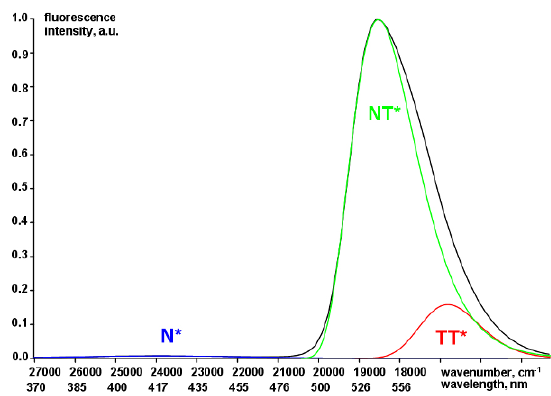
Figure 12. Possible deconvolution of bis-flavonol fluorescence spectrum in toluene onto three individual